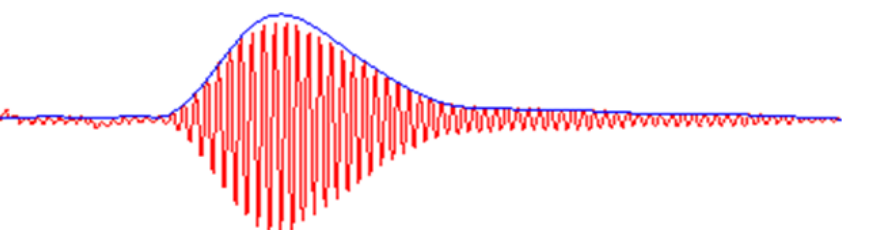
Figure 1. Ideal shape of an ultrasonic waveform. (Blue line: echo envelope; red line: raw ultra- sonic signal.)